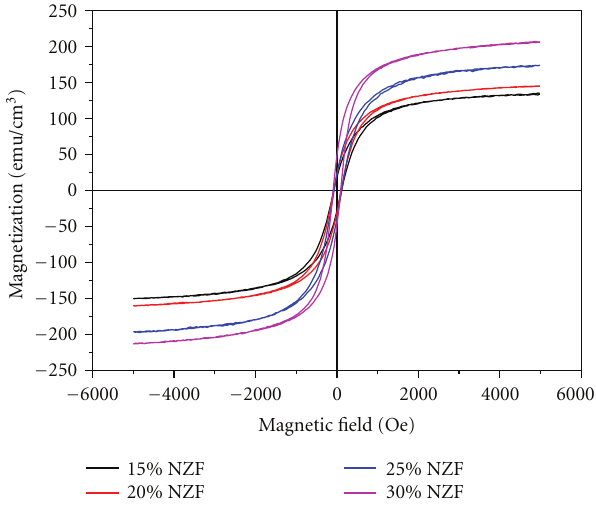
Figure 9: M-H hysteresis loops PZT-PMnN + NZF thick films by AD with di ff erent NZF content, [72].